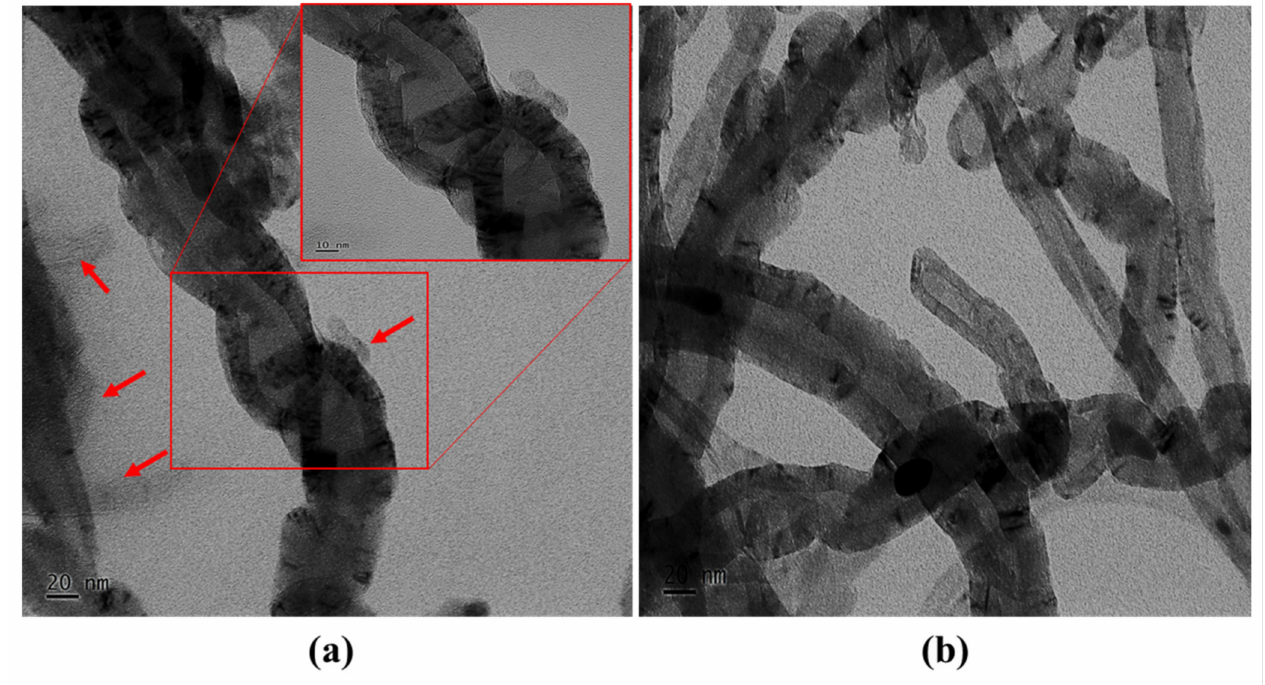
Figure 9. TEM images of ( a ) PVP coated CNTs and ( b )